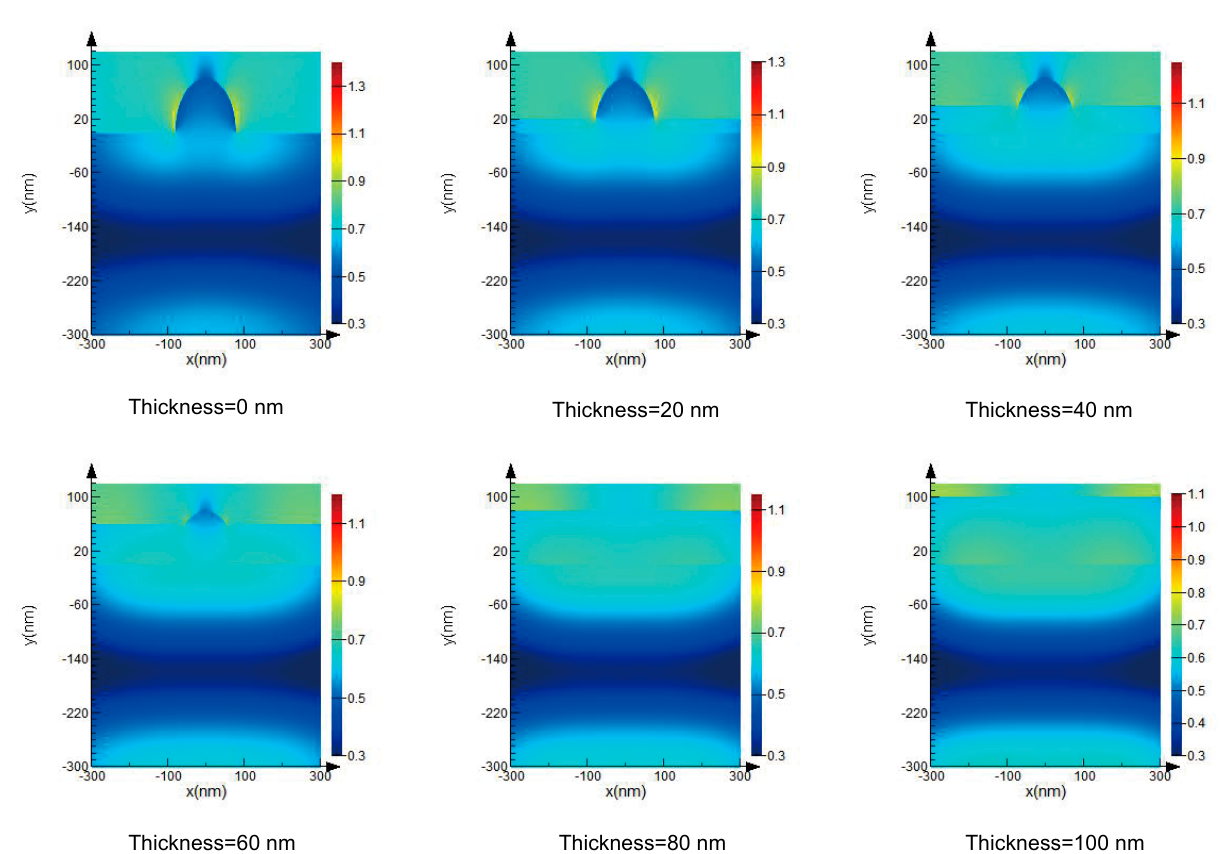
Figure 5. The coupling effect of defects and organic contamination layers of different thicknesses on the local light field of a TiO 2 optical film.